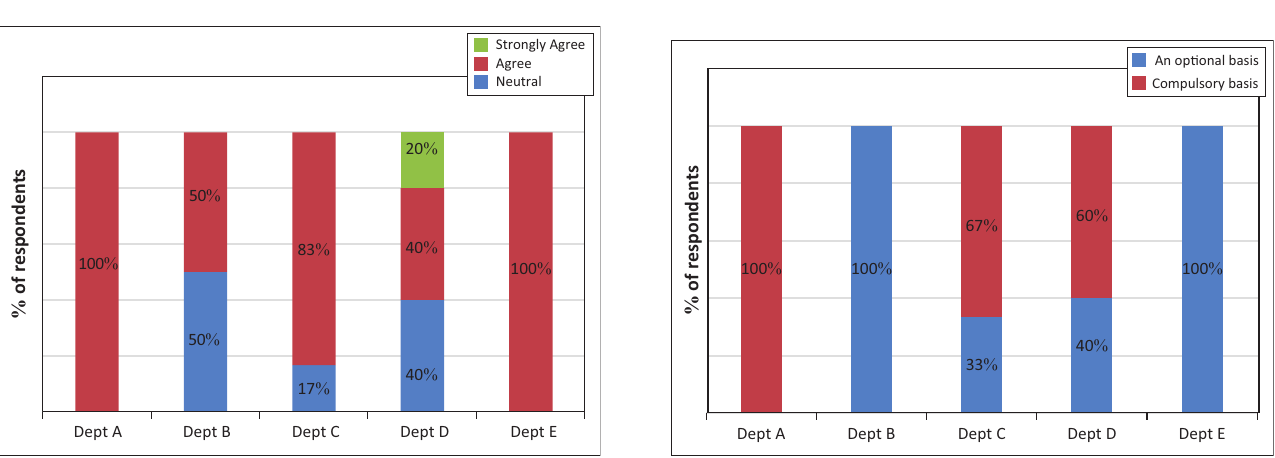
FIGURE 10: Confidence to ‘self-upload’ output.